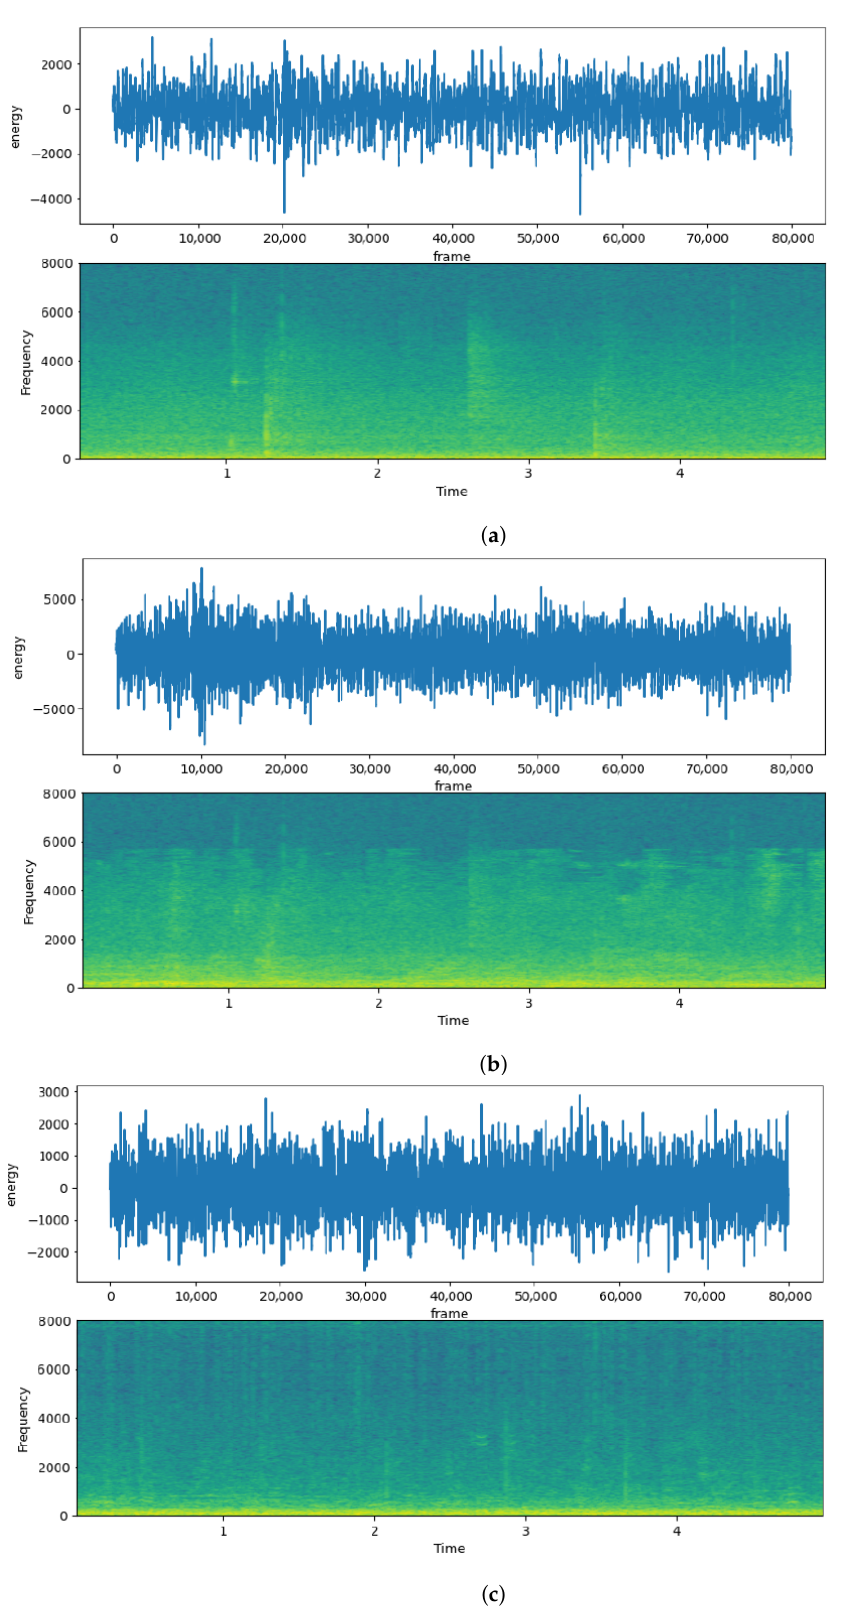
Figure 3. Sample waveform and spectrogram of a segment of five seconds from the first volunteer, during several stages of the experimental process. ( a ) Clean segment. ( b ) Noise-degraded with Office Noise SNR 0. ( c ) After the deep learning-based